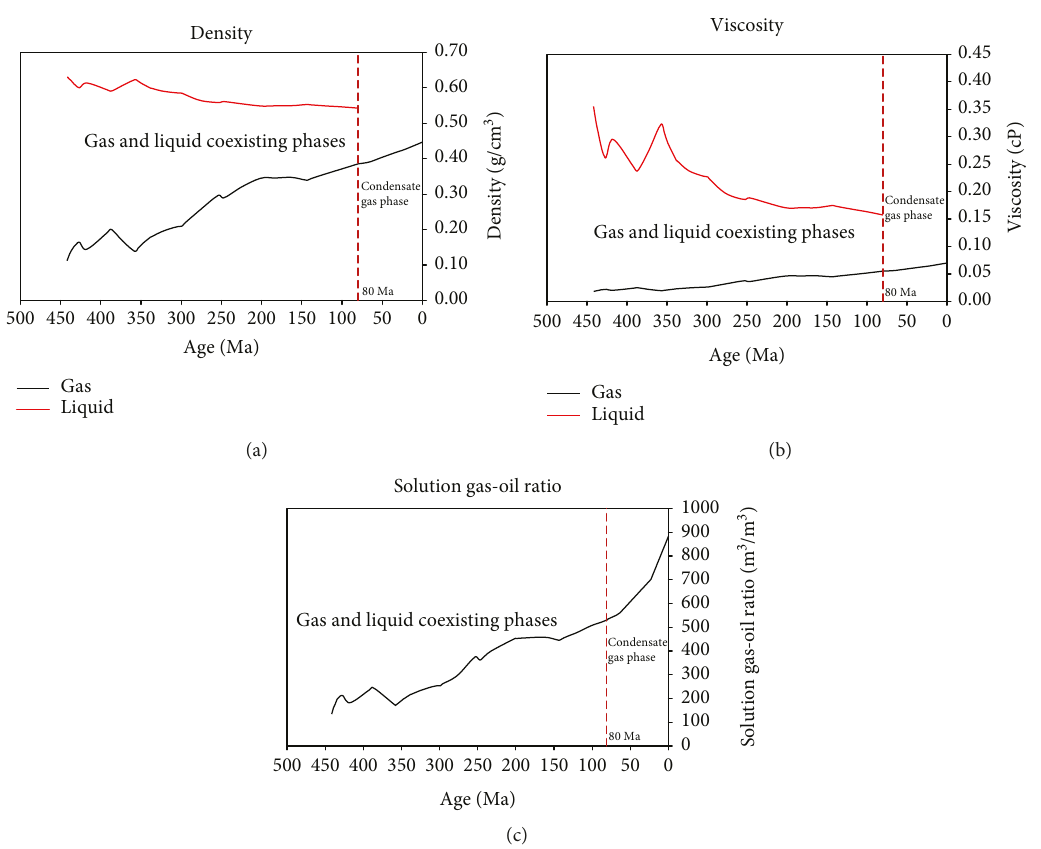
) in Well ZG7-5 (under ideal conditions). 3